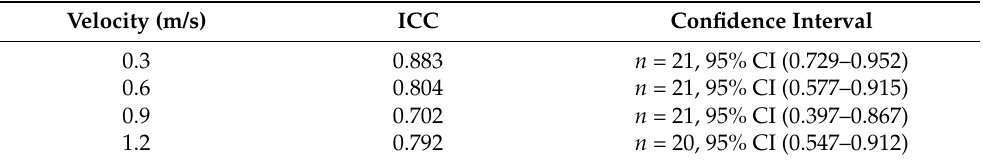
Table 2. Intraclass correlation between medial gastrocnemius peaks detected by mTrigger and DELSYS for overground walking at various walking speeds.